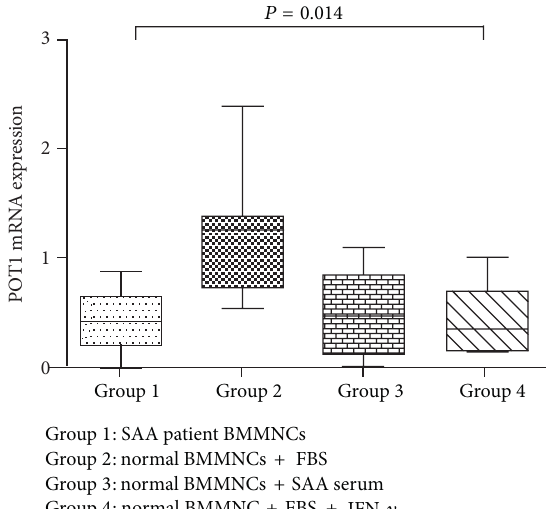
Group 1 : SAA patient BMMNCs Group 2 : normal BMMNCs + FBS Group 3 : normal BMMNCs + SAA serum Group 4 : normal BMMNC + FBS Figure 6: POT1 mRNA expression in normal BMMNCs is reduced in the presence of SAA serum or IFN- 𝛾 . POT1 mRNA expression in vitro as it does in SAA patients in vivo.